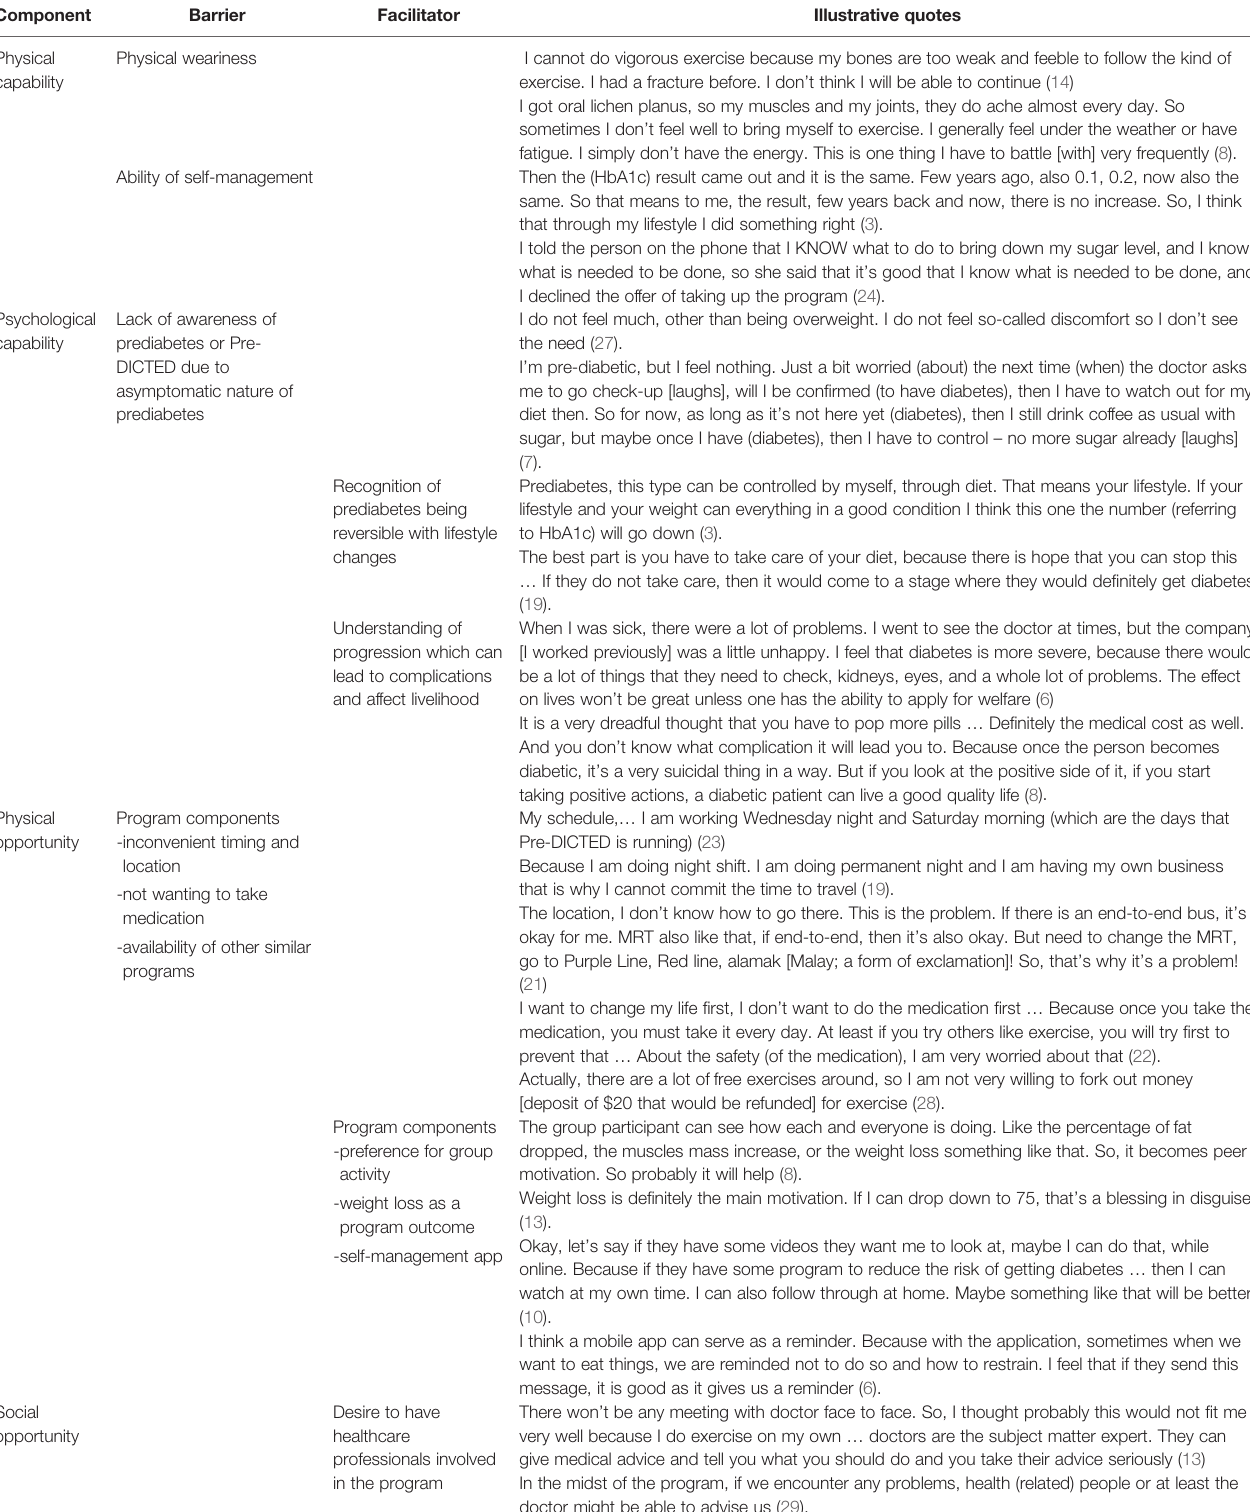
TABLE 2 | Facilitators and barriers to uptake of diabetes prevention program.